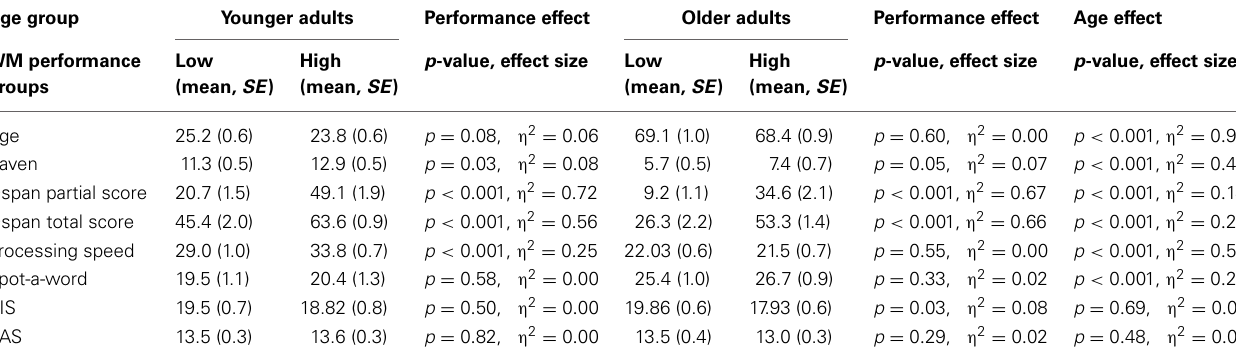
Table 1 | Psychometric variables displayed separately for the two age groups and the two working memory performance